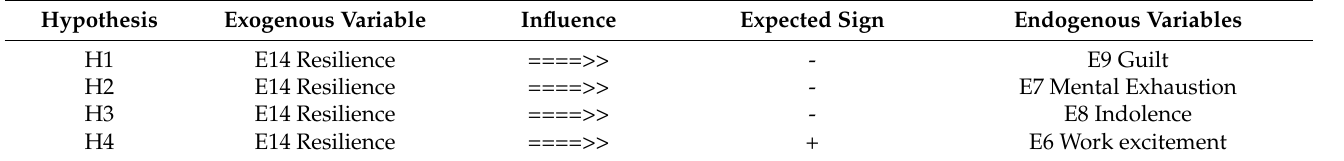
Table 1. Expected influence of the independent variable Resilience (exogenous) in connection with the dependent variables